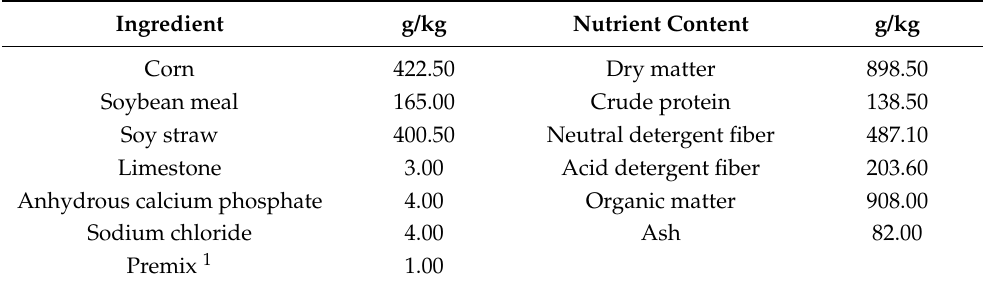
Table 1. Composition and nutrient content in the basal